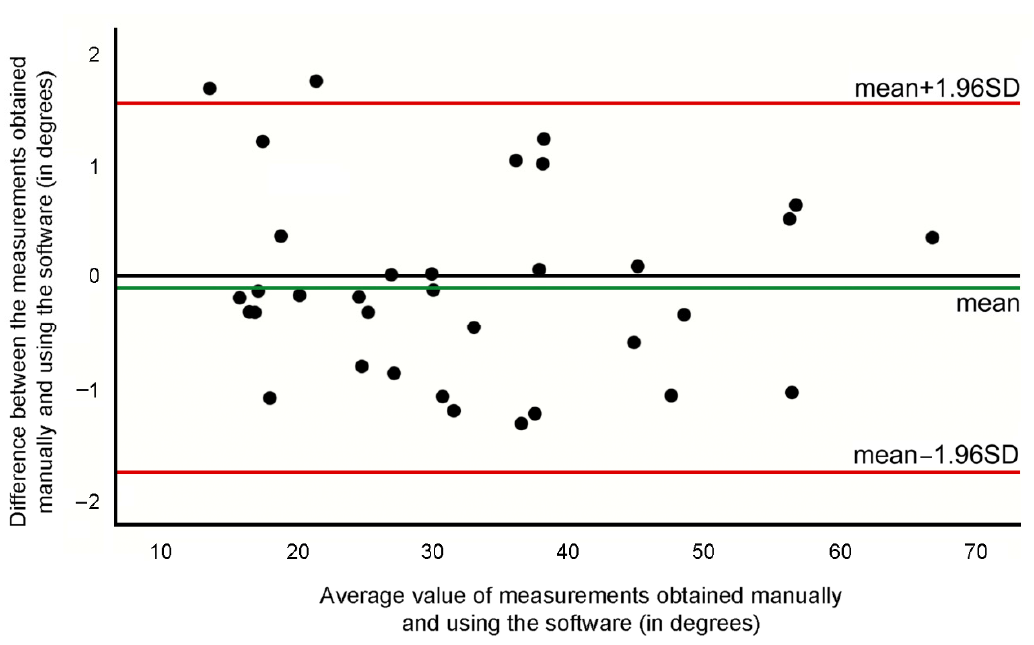
Figure 4. Bland–Altman graphic for the curves’ measurements acquired with the software and